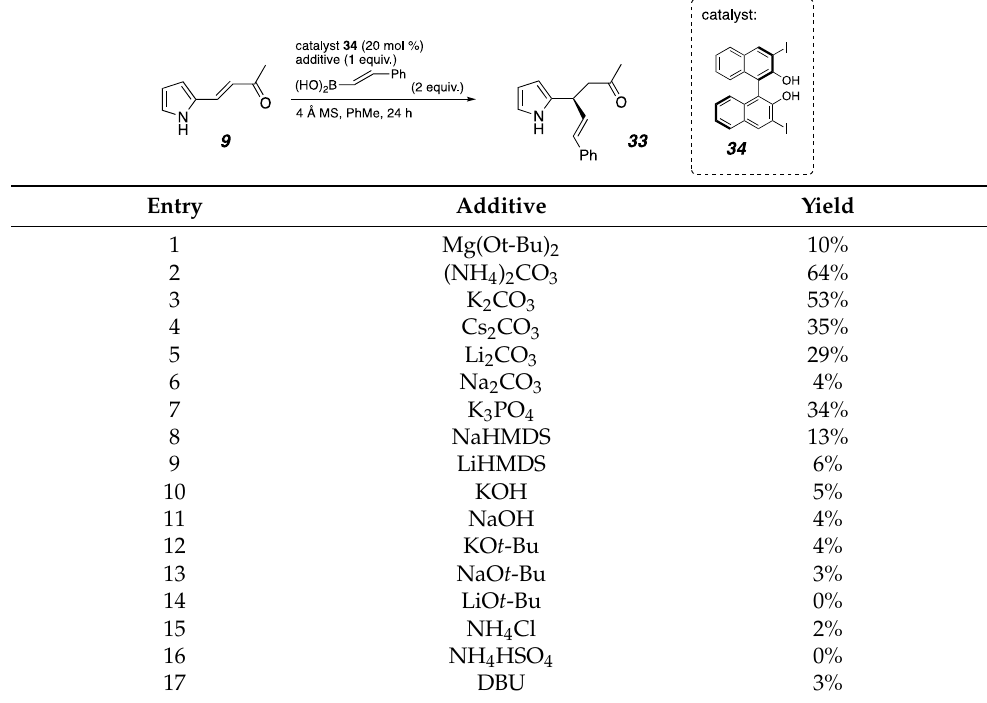
Figure 8. Pyrrole substrates. Table 1. Optimizations of additives with 2-pyrrolyl enone. 0.20 mmol 27 with 0.02 mmol catalyst